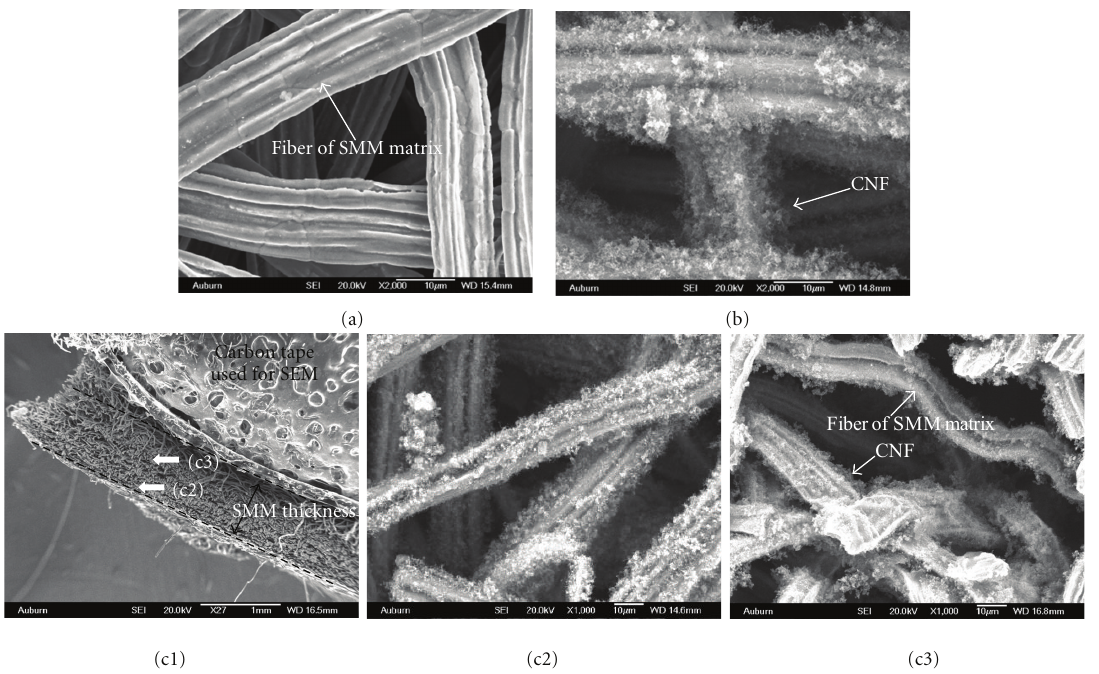
Figure 11: 3-dimensional deposition of CNF within 8 µ m SMM matrix: (a) top-view before synthesis, (b) top-view after CNF 11 min synthesis, (c1) low magnification (27x) cross-sectional view, (c2) cross-sectional view at 1000x of the matrix edge shown in c1, and (c3) cross-sectional view at 1000x of the matrix thickness centerline shown in c1